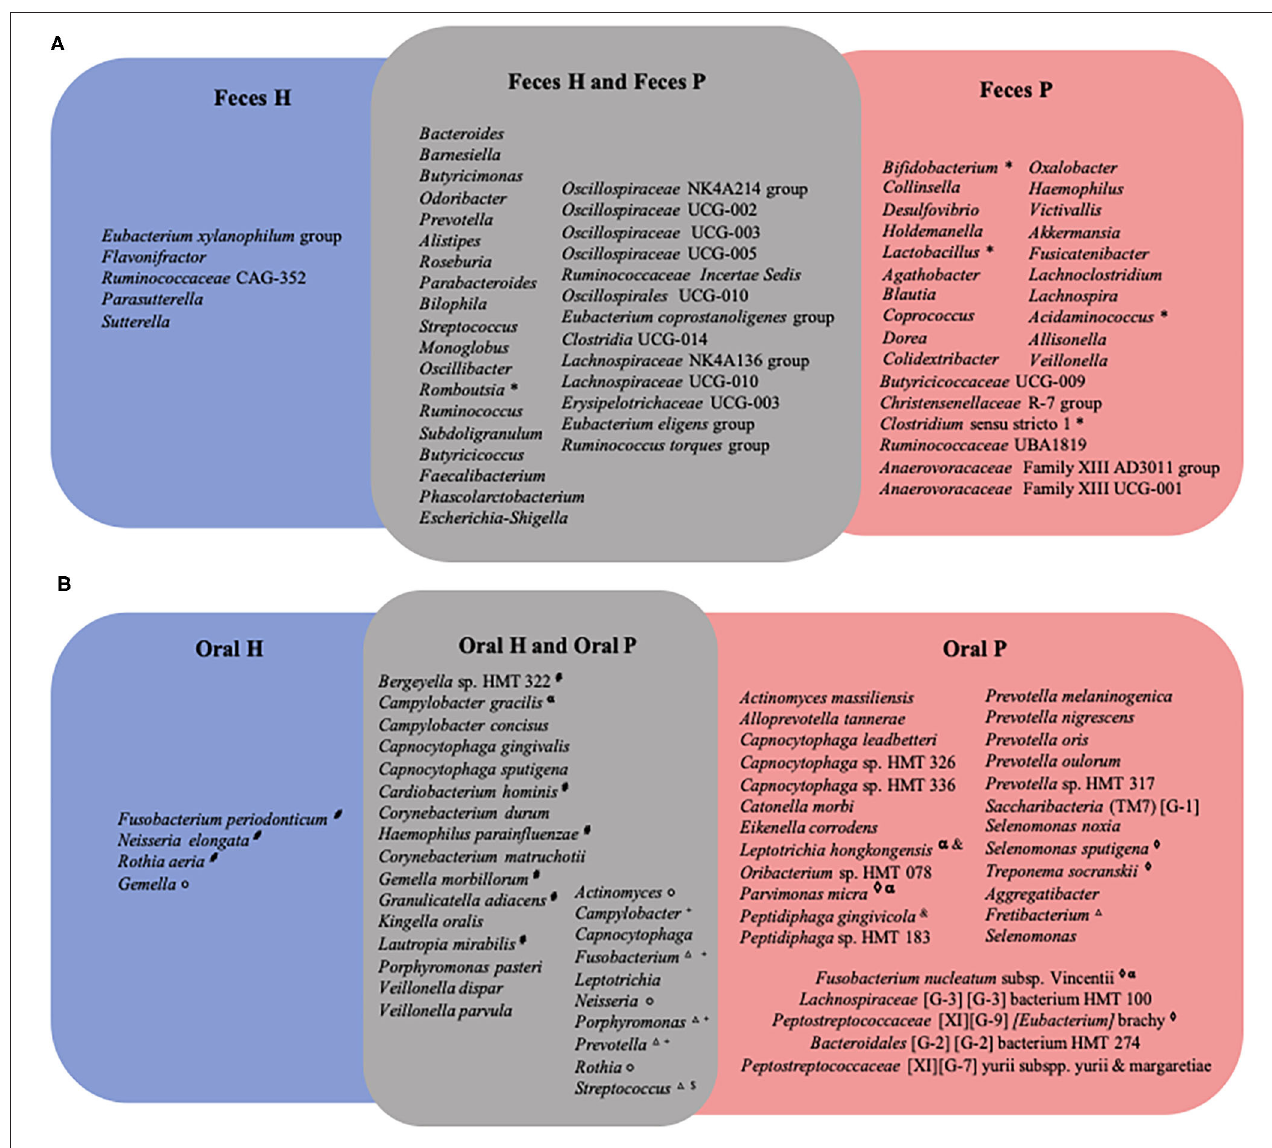
FIGURE 5 | Venn diagram of core microbiome representing bacteria genera or specie present in at least 70% of subjects. In (A) genera in feces of periodontitis patients (Feces_P) and periodontally healthy individuals (Feces_H); in (B) species in oral biofilm of periodontitis patients (Oral_P) and oral biofilm periodontally healthy individuals (Oral_H). For (*) genera that were more abundant in feces of periodontitis patients in comparison of feces of H; ( ) genera more abundant in P when subgingival affected sites of P group were compared to shallow sites of H; ( ◦ ) genera more abundant in H when subgingival affected sites of P group were compared to subgingival sites of H; ( + ) genera more abundant in P when supragingival sites of P were compared to supragingival sites of H; ( $ ) genera more abundant in H when supragingival sites of P were compared to supragingival sites of H; ( 1 ) genera more abundant in P when subgingival shallow sites of P were compared to subgingival shallow sites H; ( α ) species more abundant in supragingival sites of P than supragingival sites of H; ( & ) species more abundant in subgingival non-affected sites of P than subgingival sites of H; ( ♦ ) species more abundant in subgingival affected sites of P group when were compared to subgingival sites H; ( # ) species more abundant in subgingival sites of H when compared to subgingival affected sites of P